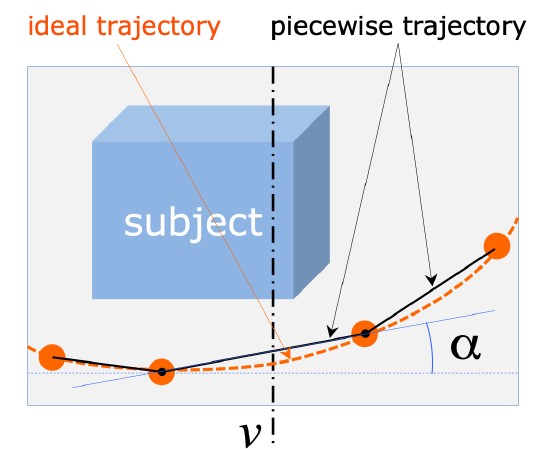
Figure 5. Efficient estimation of the angle α from the position of the trajectory markers: α is simply the slope of the linear segment connecting the two markers lying nearest and on opposite sides of v